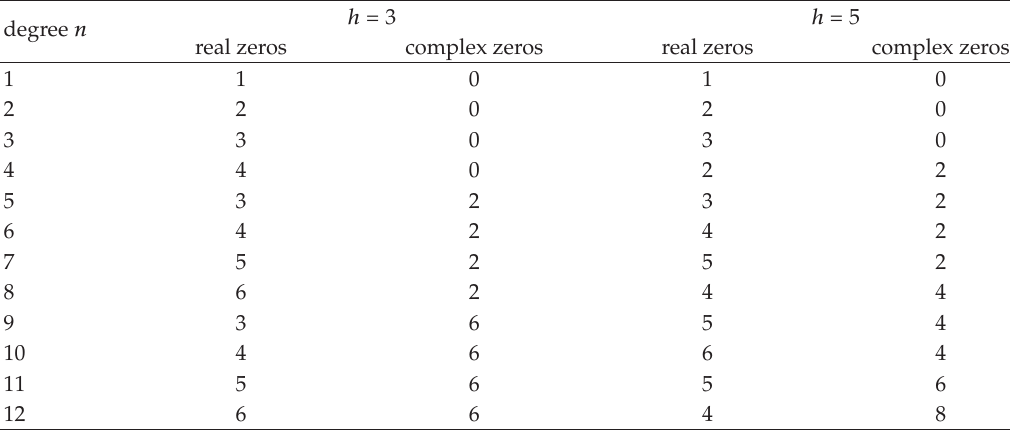
Table 1: Numbers of real and complex zeros of B